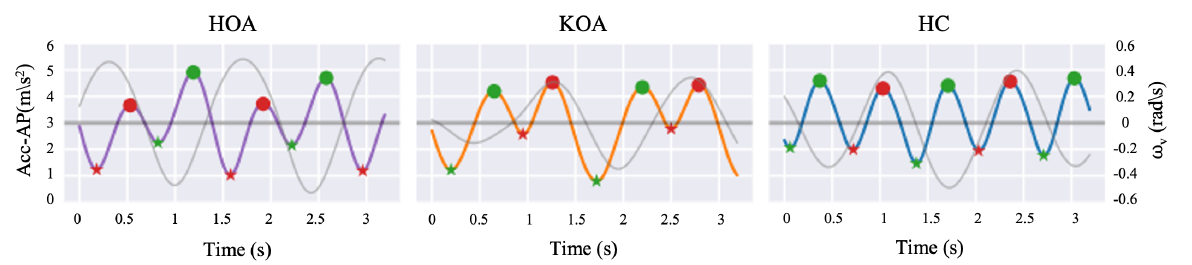
Figure 10. Filtered AccAP signal for HOA ( purple line ), KOA ( orange line ), and HC ( blue line ), and vertical angular velocity ( gray line ) along a few steps are depicted. Local maxima and minima in the AccAP signal correspond to HSs (filled circles) and TOs (asterisks), respectively. The red color represents the left foot, while the green color represents the right